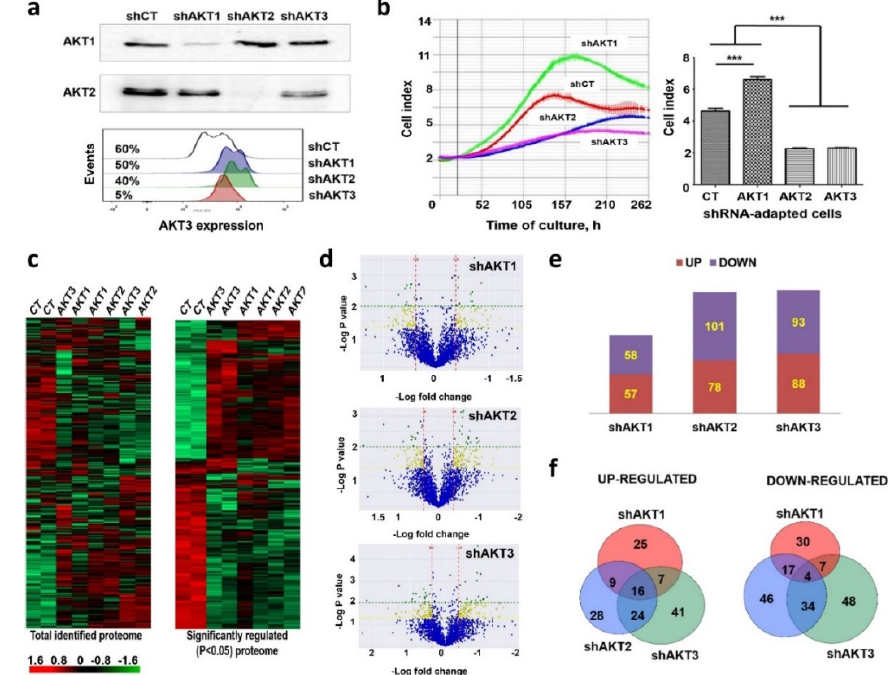
Figure 1. Adaptation of human pancreatic adenocarcinoma cells to specific silencing of AKT isoforms. ( a ) Immunoblots on top, detection of the indicated AKT kinases in cell lines constitutively expressing the shRNA named on top. Original uncropped Western blots and densitometry readings are shown in Figure S1,2. Below, flow cytometry histogram of AKT3 expression in the cell lines expressing the indicated shRNAs shown on the right. Percentages of AKT3-expressing cells are shown. The results shown correspond to analyses after more than 20 cell passages after adaptation. ( b ) Left, RTCA graph depicting the growth of the cell lines expressing the indicated shRNAs after adaptation. Right, column graph plotting Cell Index from RTCA data, with means and standard deviations as error bars (four replicates). Relevant statistical comparisons are shown by ANOVA and Tukey’s pairwise tests. ( c ) Left, cluster analysis of the complete identified proteome from cells adapted to silencing of the indicated AKT isoforms, shown as a heat map. Right, same as left but with significantly regulated ( p < 0.05) proteins as identified by ANOVA. Red, upregulated genes; Green, downregulated genes; Black, unchanged expression. ( d ) Volcano-plots representing fold-change di ff erences for identified proteins using pair-wise comparisons between shCT-control cells and cell lines adapted to silencing of the indicated AKT isoforms as shown on top of each plot. Blue, proteins without significant changes; Yellow, di ff erentially expressed proteins, p < 0.05; Green, di ff erentially expressed proteins, p < 0.01. ( e ) bar graph of the number of significantly upregulated (red) and downregulated (blue) proteins identified in the volcano plots. ( f ) Venn diagrams of di ff erentially upregulated (left) or downregulated (right) proteins in the indicated cell lines with each silenced AKT isoform. Overlaps are shown, together with the number of overlapping identified proteins indicated within the circles. shCT, control shRNA; ***, highly significant ( p < 0.001) di ff erences.